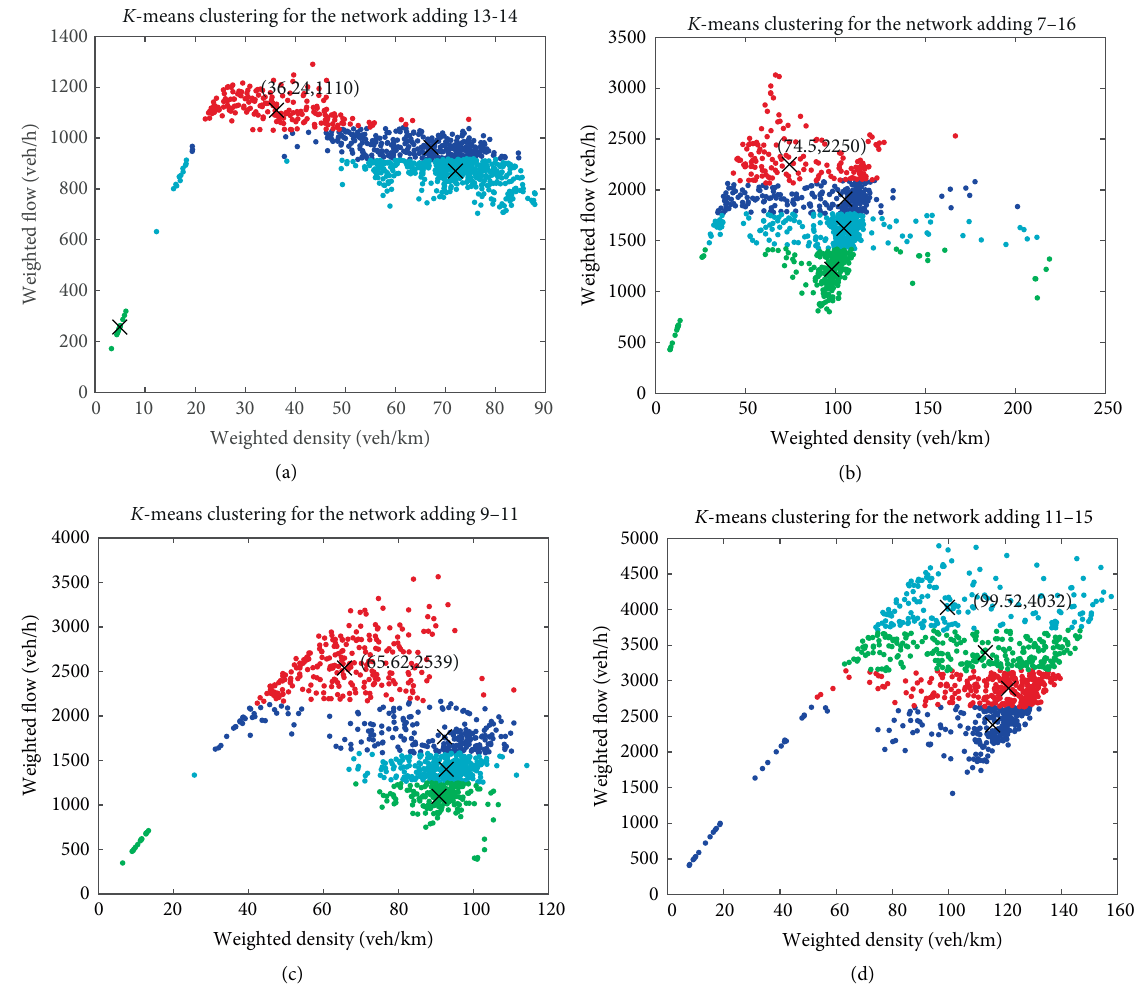
Figure 7: MFDs and capacities of four extended Sioux Falls